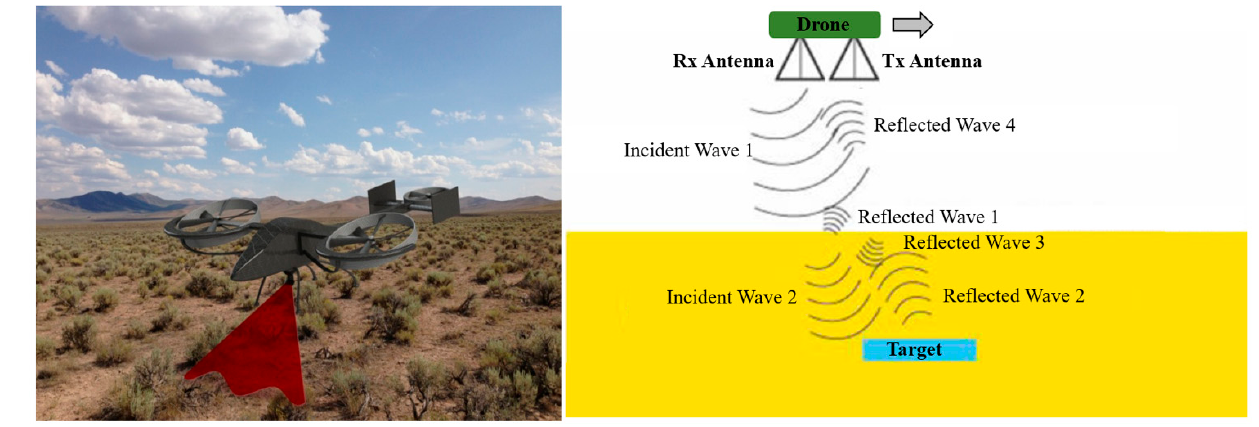
Figure 1. Airborne high-power sub-Terahertz-radiation underground